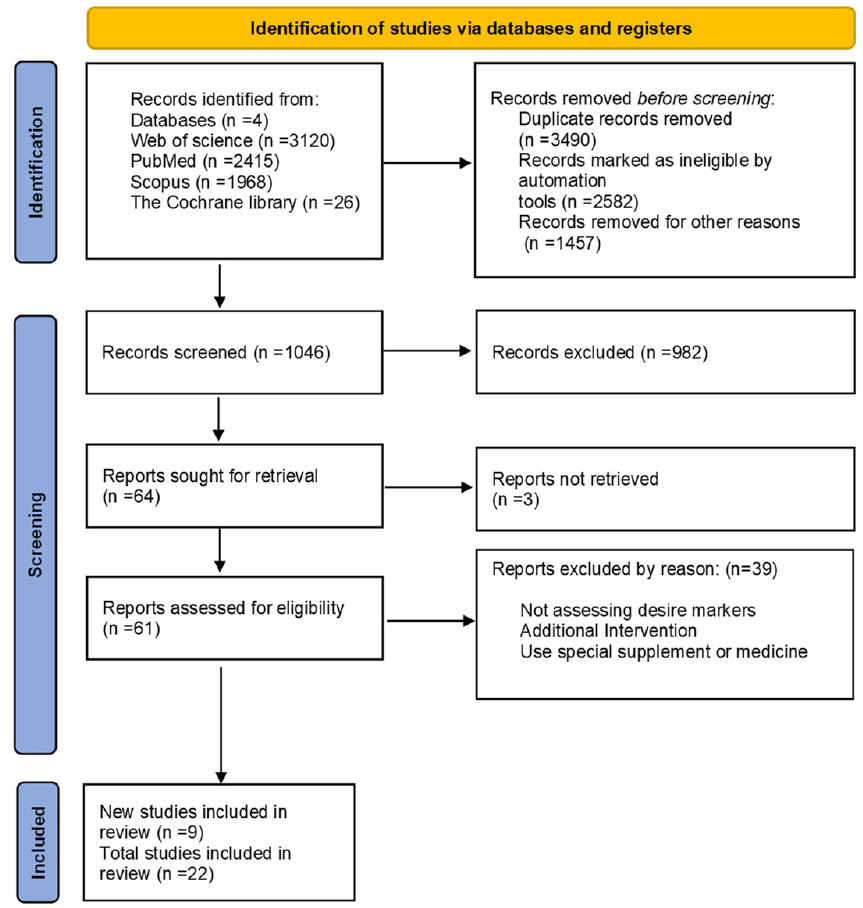
Figure 1. PRISMA flow diagram study selection and inclusion process .